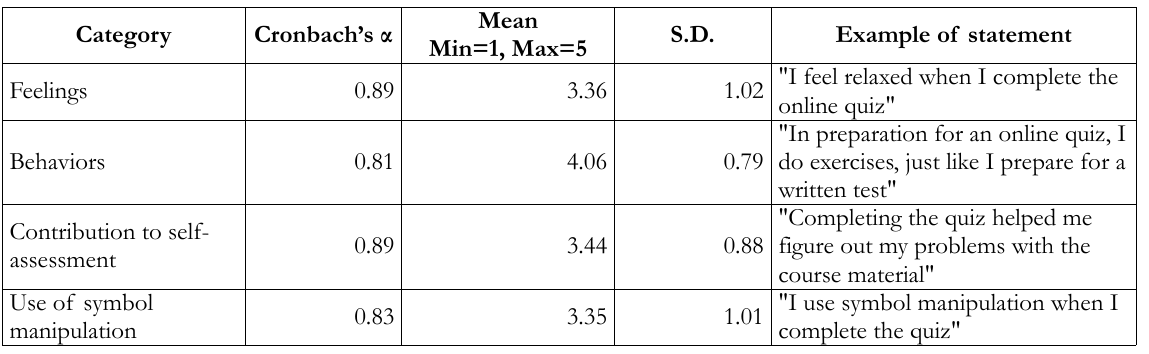
Table 2. Student attitudes toward online quizzes, organized by